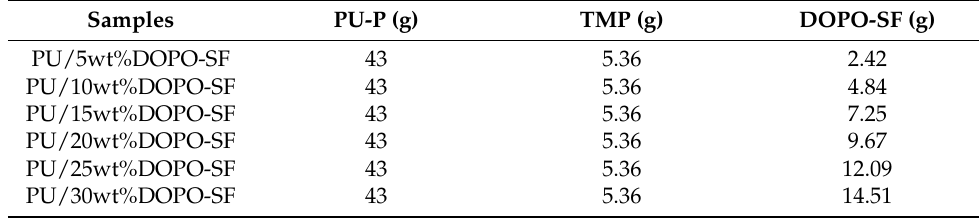
Table 2. Feeding ratio of IFRPU-PSA samples for PU/DOPO-SF.